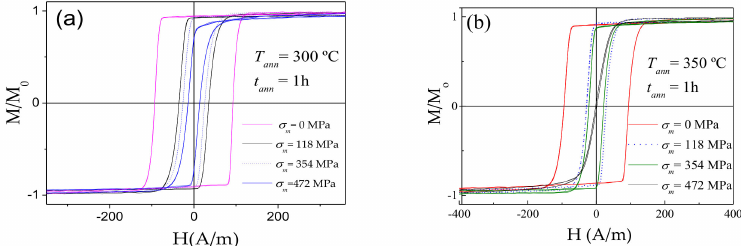
Figure 7. Hysteresis loops of Co 69.2 Fe 3.6 Ni 1 B 12.5 Si 11 C 1.2 Mo 1.5 microwires annealed at T ann = 300 ◦ C ( a ) and T ann = 350 ◦ C ( b ) for di ff erent σ m